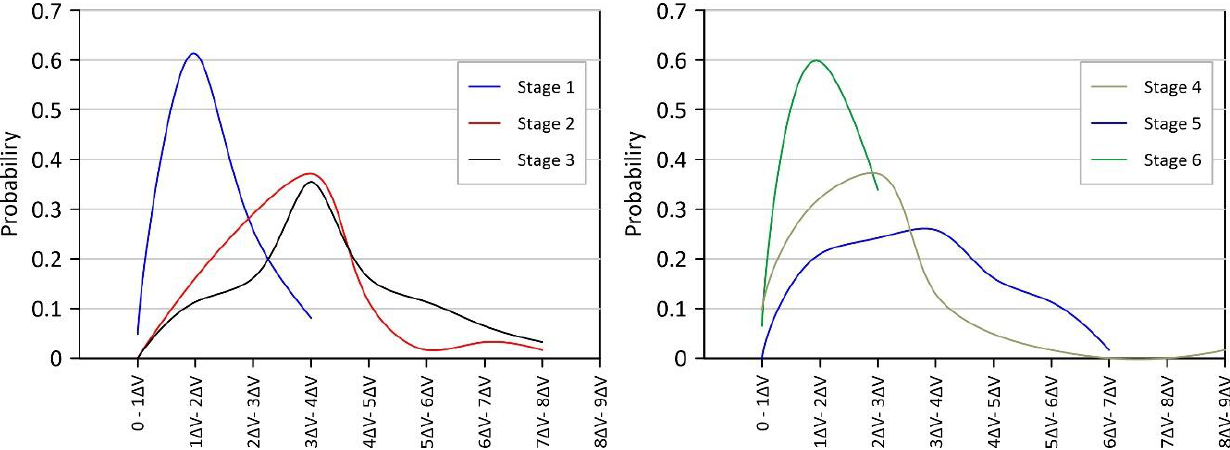
Figure 4. Probability values for La Angostura dam.